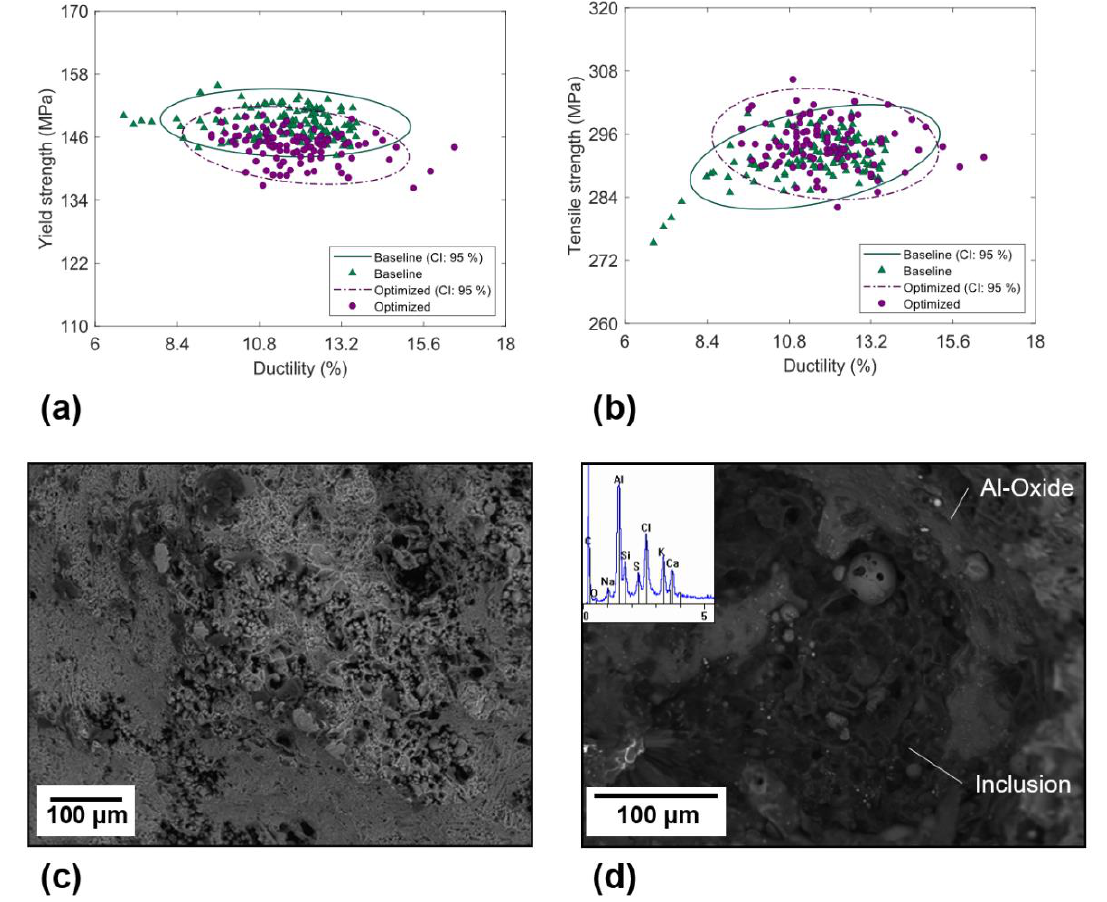
Figure 2. Tensile properties of samples produced using the ( a ) Baseline , and ( b ) Optimised plunger speed profiles; 95% confidence ellipses are shown for two-dimensional, normally distributed data. Shown in ( c , d ) are representative backscattered electron micrographs of pores and inclusions observed on the fracture surface of tensile specimens, respectively [26].